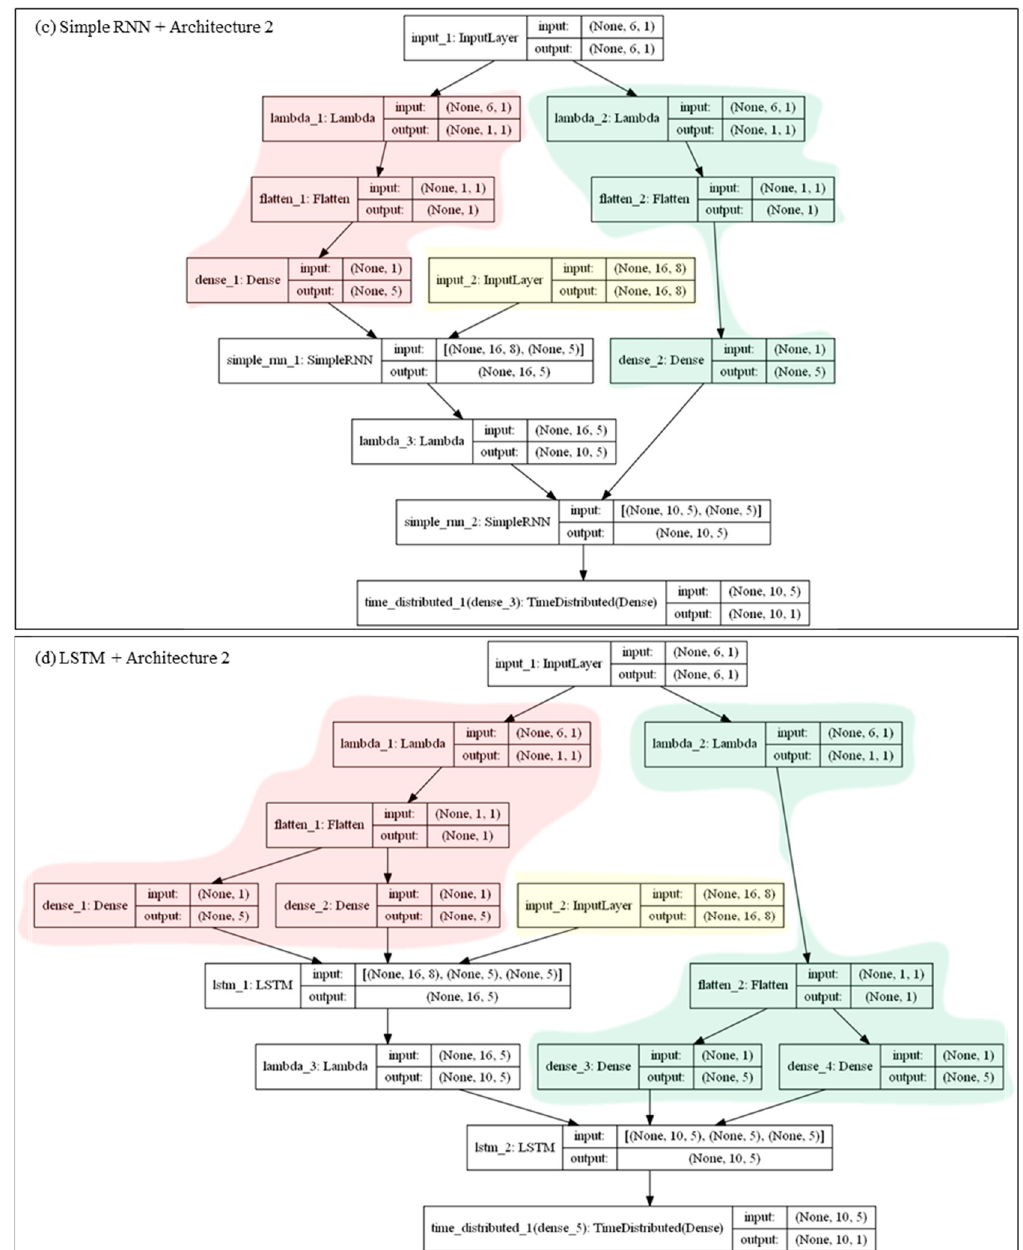
Figure 9. Visualization of tensor flow in ML models.